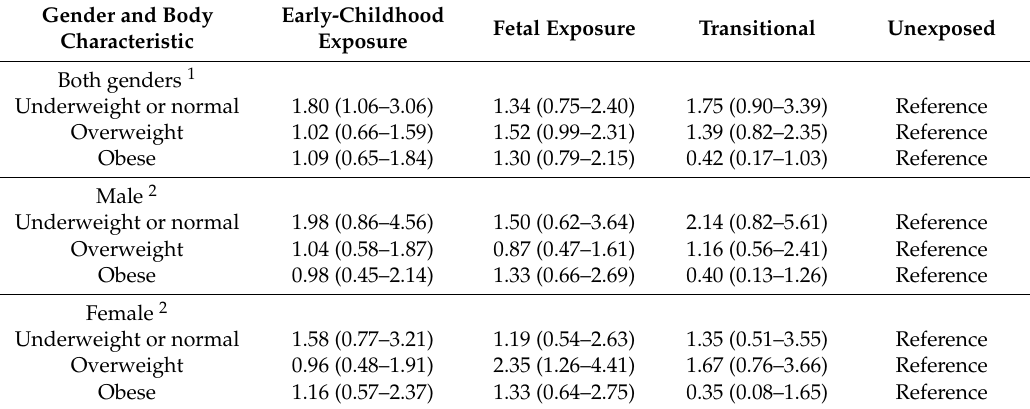
Table 4. Associations between the Chinese famine exposure and risk of diabetes stratified by BMI after adjusting for